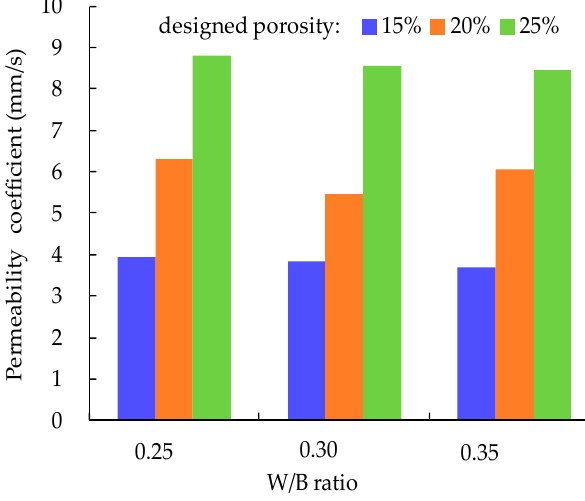
Figure 8. Relationship between permeability coefficient, designed porosity and W/B ratio.